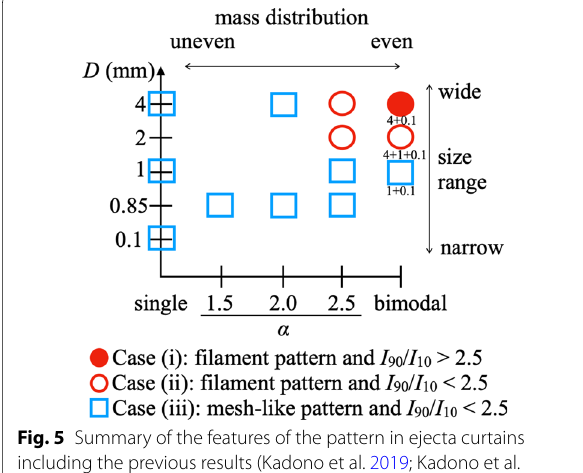
Fig. 5 Summary of the features of the pattern in ejecta curtains including the previous results (Kadono et al. 2019; Kadono et al. 2020a). The horizontal axis is the size distribution of particles and the vertical axis is the maximum size of particles. The closed circle, open circles, and open squares indicate case (i) (filament structure and I 90 / I 10 > 2.5), case (ii) (filament structure and I 90 / I 10 < 2.5), and case (iii) (mesh-like structure and I 90 / I 10 < 2.5), respectively. The result for the mixture of particles with 4, 1, and 0.1 mm is plotted as a